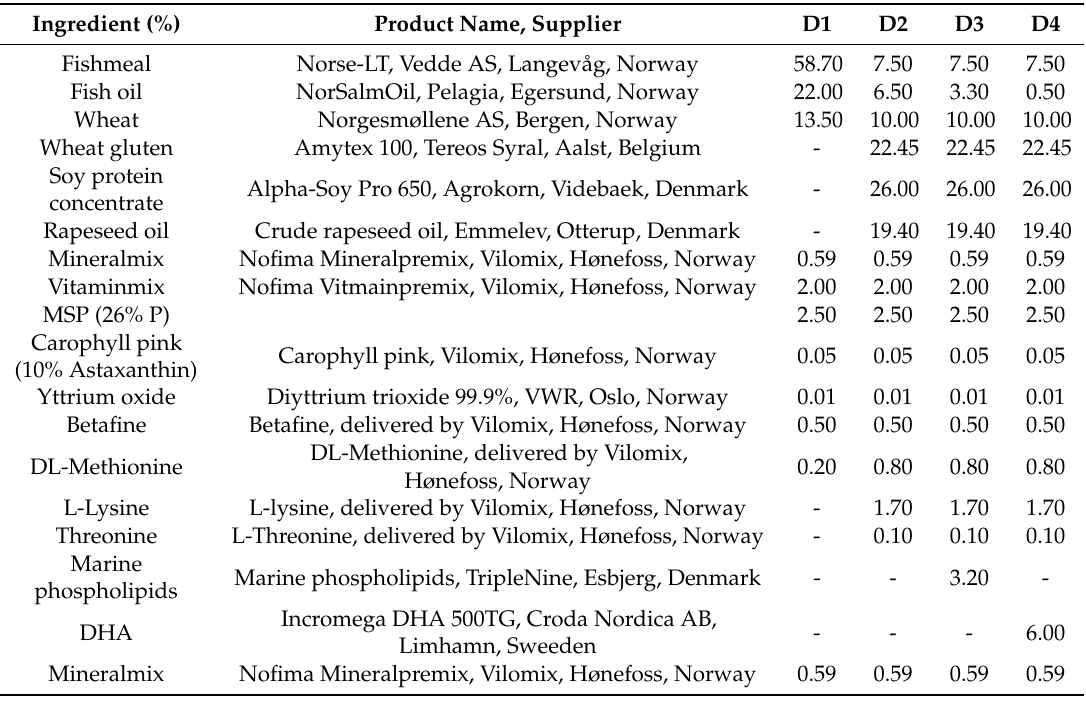
Table 1. Diet composition. D1—rich marine diet; D2—poor marine diet; D3—poor marine diet